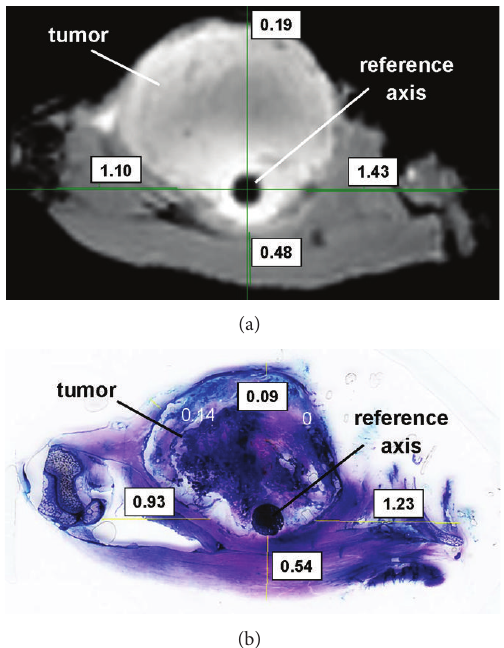
Figure 1: Example of a histological slice (b) associated with its corresponding MRI slice (a) of the same excised tumor specimen for the comparison of the two measurement methods. In this case, the reference axis for the measurements is the wood stick inserted in the excised specimen. Resection margins are measured in mm along the straight lines drawn manually by the